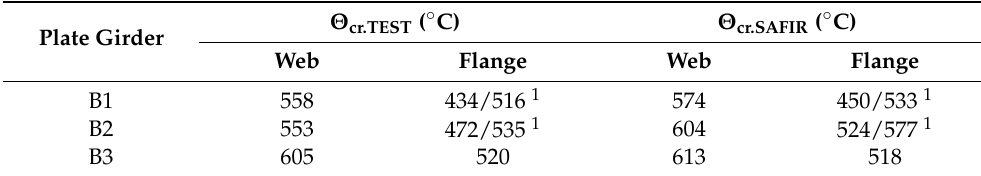
Table 4. Critical temperature: Θ cr.TEST —experimental study, Θ cr.SAFIR —numerical simulation. Plate Girder